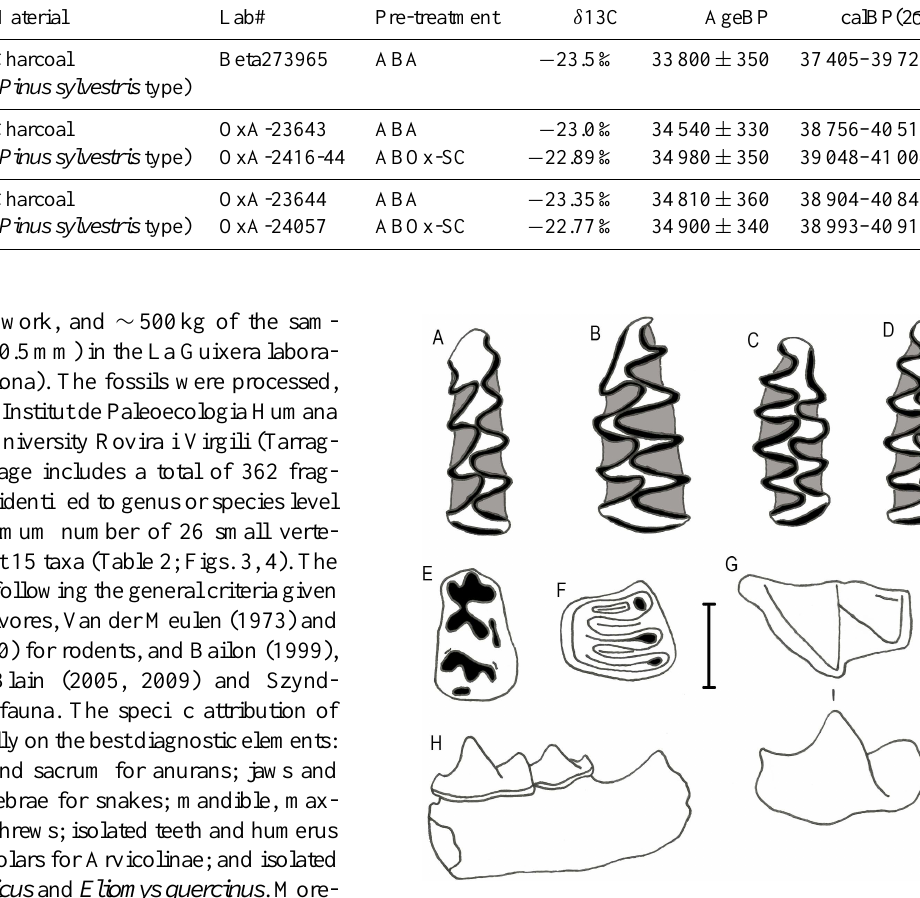
Fig. 3. Some small mammals from Canyars. A: first left lower mo- lar (m1) Microtus ( Terricola ) duodecimcostatus (occlusal view); B: m1 left Microtus ( Iberomys ) cabrerae (occlusal view); C: m1 right Microtus agrestis (occlusal view); D: m1 right Microtus ar- valis (occlusal view); E: m1 right Apodemus sylvaticus (occlusal view); F: m1 right Eliomys quercinus (occlusal view); G: third left lower molar (m3) Talpa europaea (occlusal and labial views); H: left mandible (m2-m3) Crocidura sp. Scale